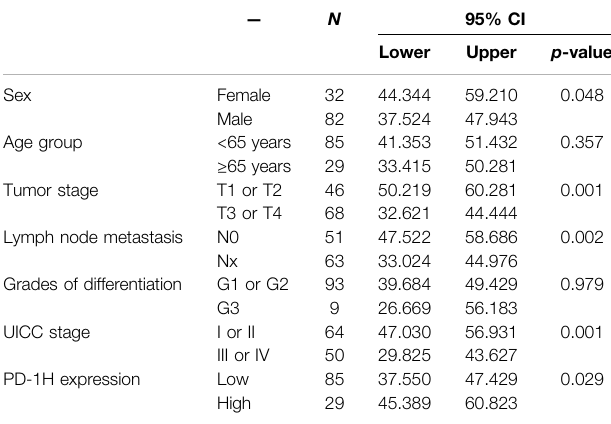
TABLE 2 | Univariate Kaplan – Meier analyses of prognostic parameters in 114 patients with ESCC.